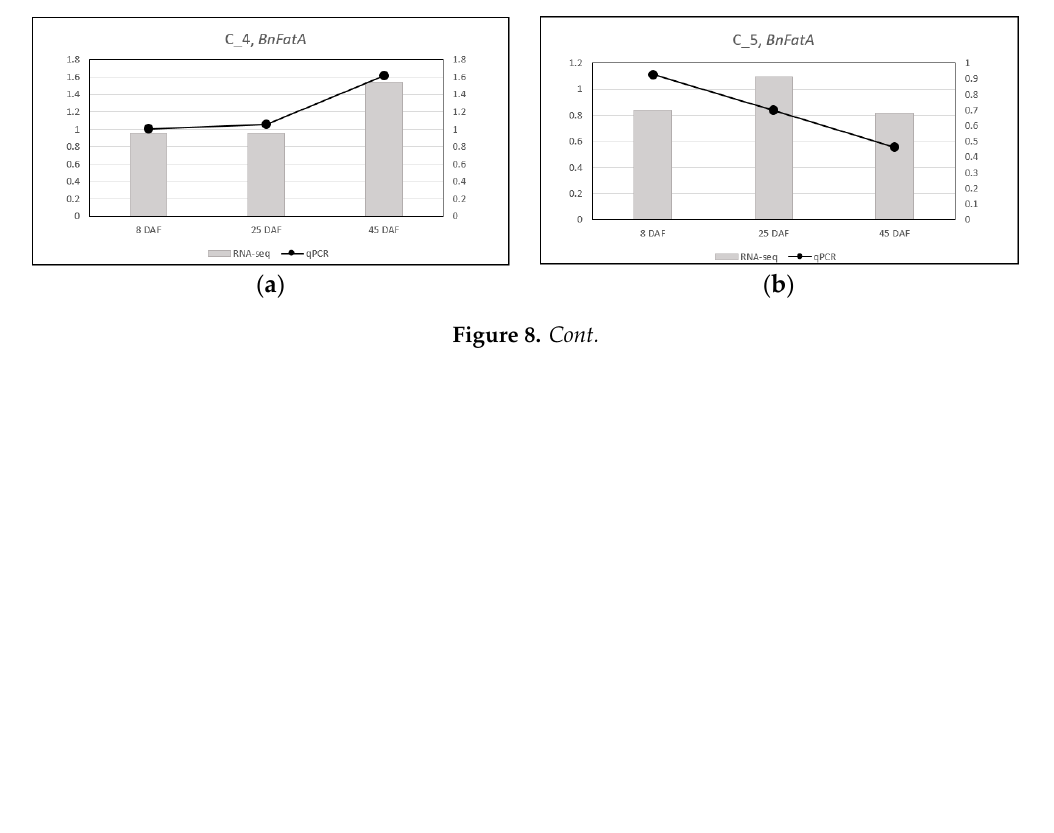
Figure 7. Comparison of RNA-Seq and RT-qPCR expressions of CpFatB4 and CpFatB5 transgenes. ( a ) 4-CpFatB4: CpFatB4 gene expression in developing pods of CpFatB4 transgenic plant. ( b ) 5-CpFatB5: CpFatB5 gene expression in developing pods of CpFatB5 transgenic plant. Primary axis (left vertical axis) values are for RNA-Seq and secondary axis (right vertical axis) values are for RT-qPCR.